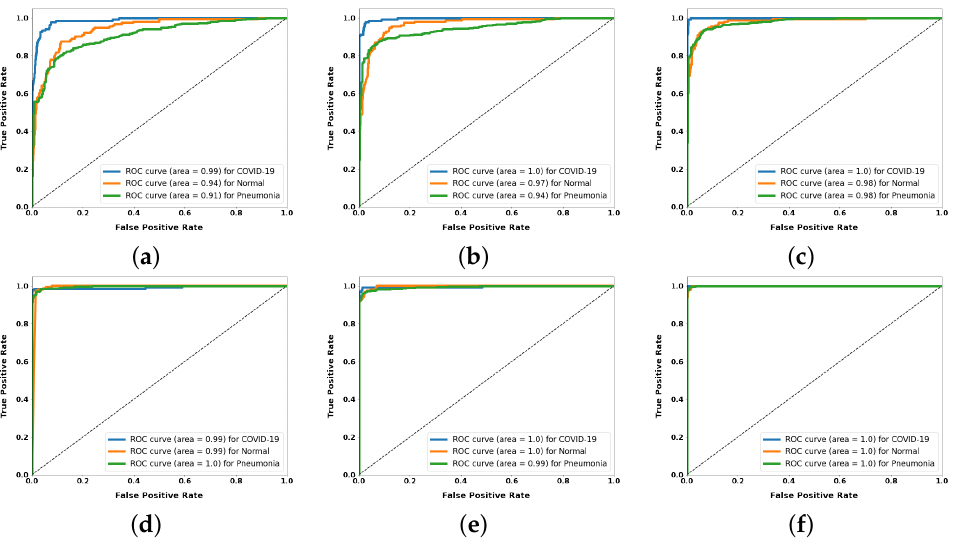
Figure 8. ROC curves of the proposed model using the ELU activation function ( α = 0.2) with different